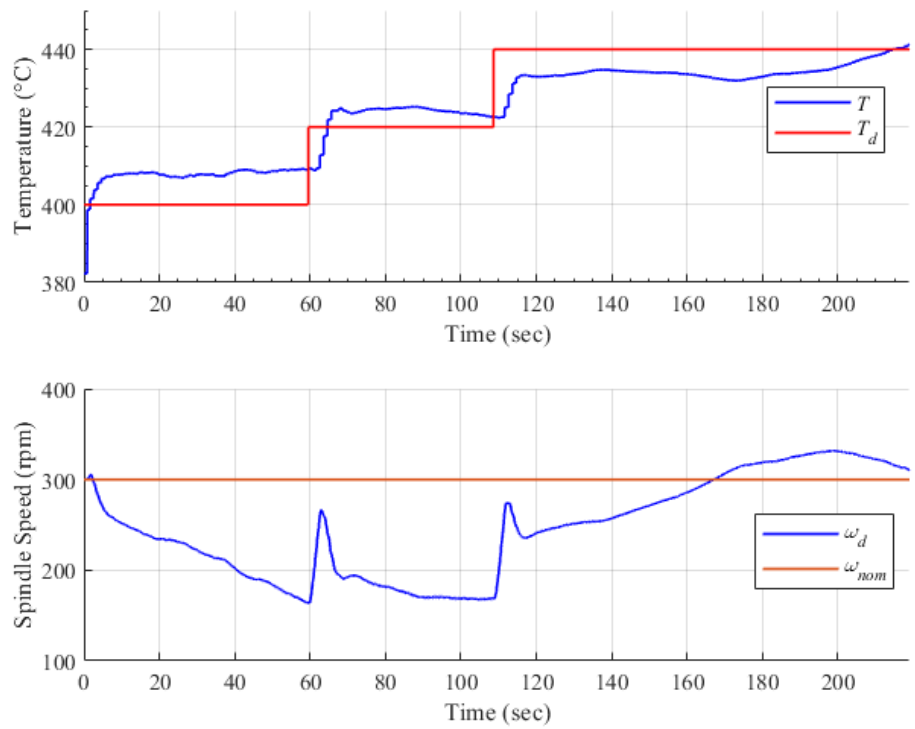
Figure 11. Protocol D. ( Top ) The desired versus measured temperature. The desired temperature was manually increased at t ≈ 59 s and t ≈ 108 s. A maximum error of 8.1 ◦ C occurs at t ≈ 170 s. ( Bottom ) The desired and nominal spindle speeds. The desired spindle speed is calculated using (3)–(7) and serves as the reference for the inner loop spindle